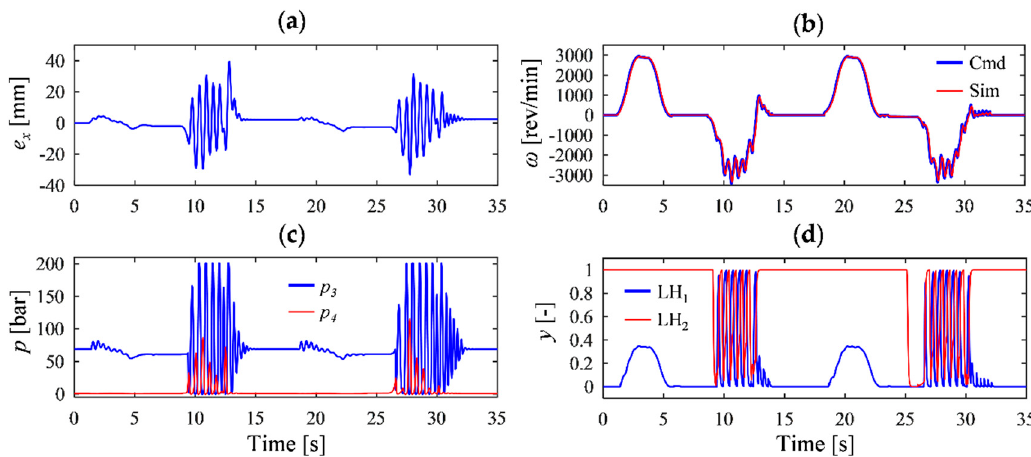
Figure 16. Simulation of the system depicted in Figure 15: ( a ) Actuator’s position error; ( b ) speed of the servo-motor; ( c ) Pressures in the actuator chambers; and ( d ) poppet lift of the load-holding valves.